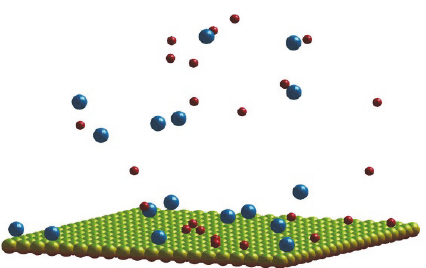
Figure 4: Competitive adsorption between particles of two species for equivalent adsorption sites on homogeneous surface.